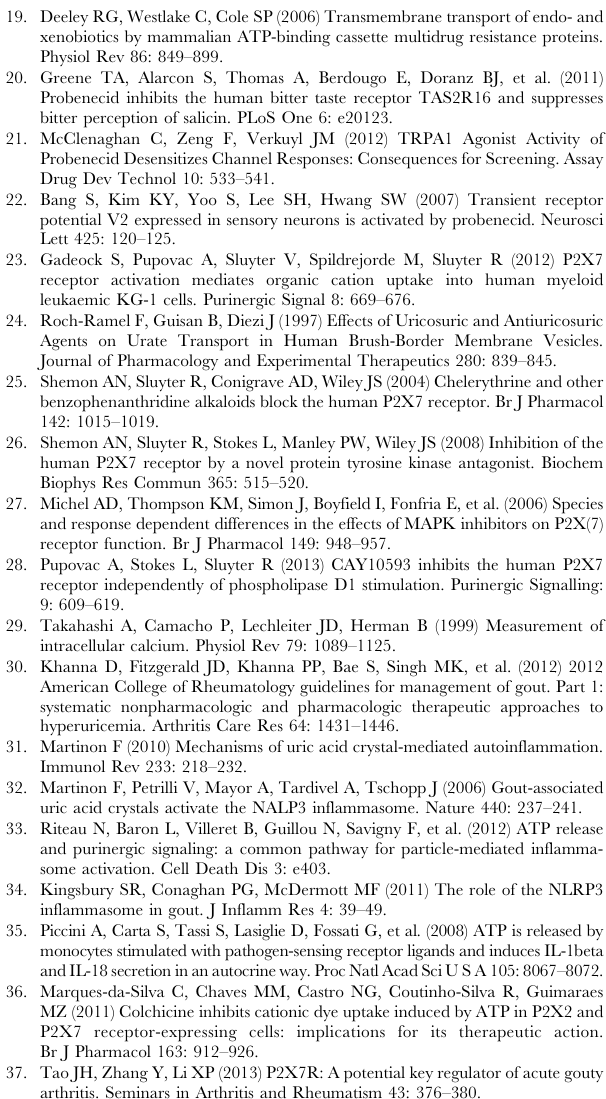
experiments. (TIF) Figure S2 Pannexin-1 antagonists have no inhibitory effect on ATP-induced dye uptake in human monocytes. Ethidium + uptake was induced in CD14-APC labelled human monocytes by the addition of 1 mM ATP (denoted by the arrow) in low divalent KCl buffer in the absence and presence of 50 m M CBX (blue, top panel), 100 m M 10 Panx1 (red, middle panel), or 10 m M A-438079 (open circles, bottom panel). Dye uptake was measured on a FACSCalibur flow cytometer using a heated time- resolved module. A representative uptake curve is shown from several